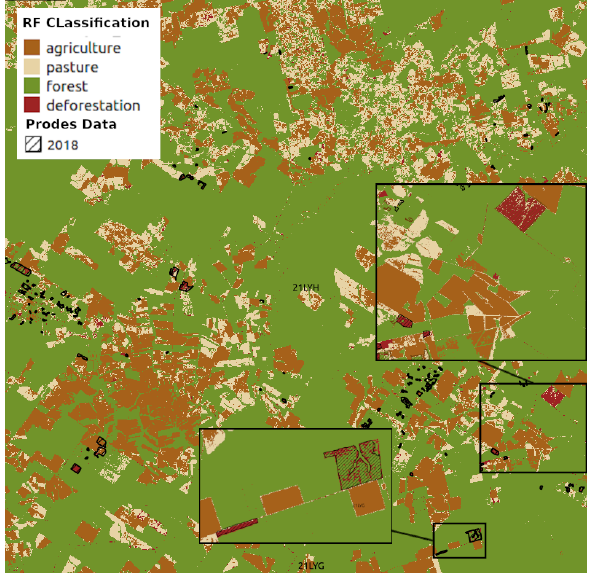
Figure 6. PRODES and RF Classification with index SAVI at tile 21LYH of January 2018 with